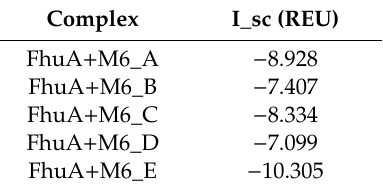
Table 2. Interface score of the selected complex in global docking simulations for each peptide